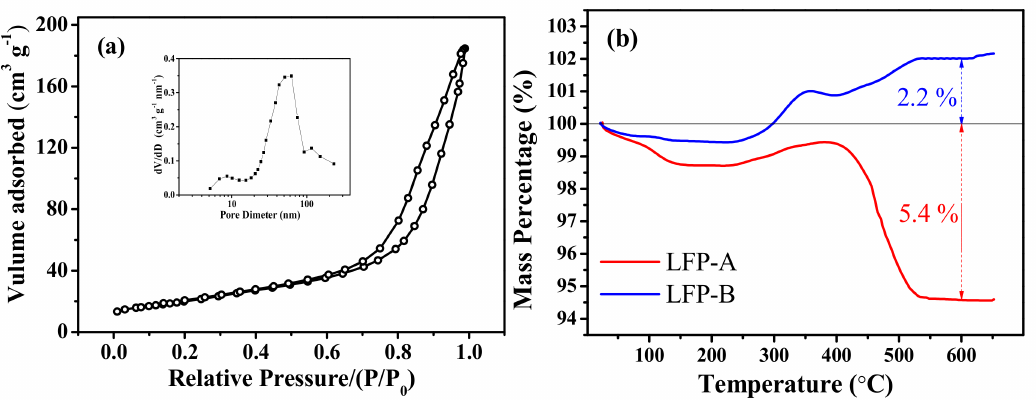
Figure 4. ( a ) Nitrogen adsorption-desorption isotherm curve of LFP-A sample; and ( b ) TG curves of the samples with a heating rate of 10 ◦ C min − 1 in